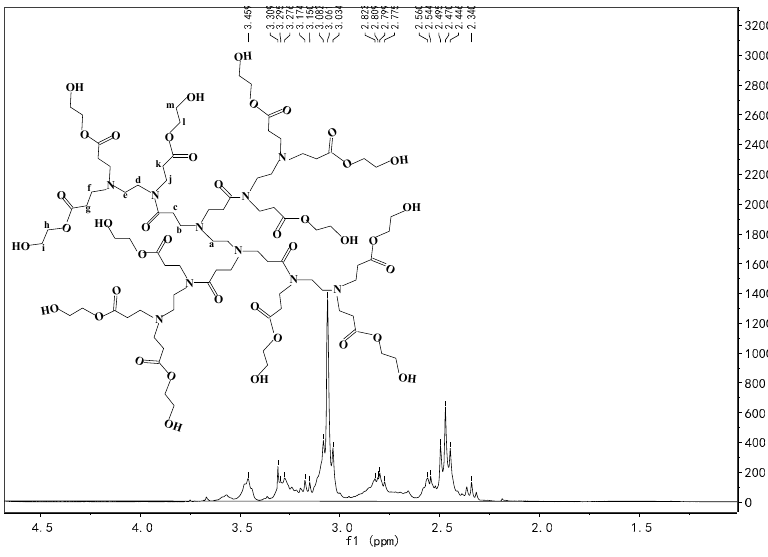
Figure 1. 1 H NMR spectra of the hyperbranched polymer reactor.